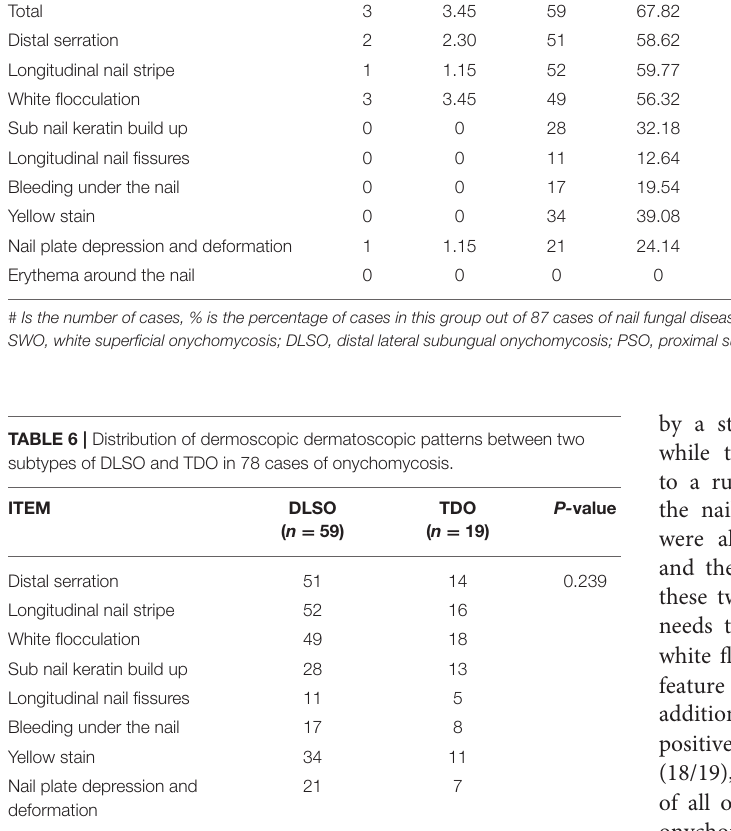
TABLE 5 | Clinical typing and dermoscopic pattern distribution of 87 patients with onychomycosis. SWO DLSO PSO TDO TOTAL